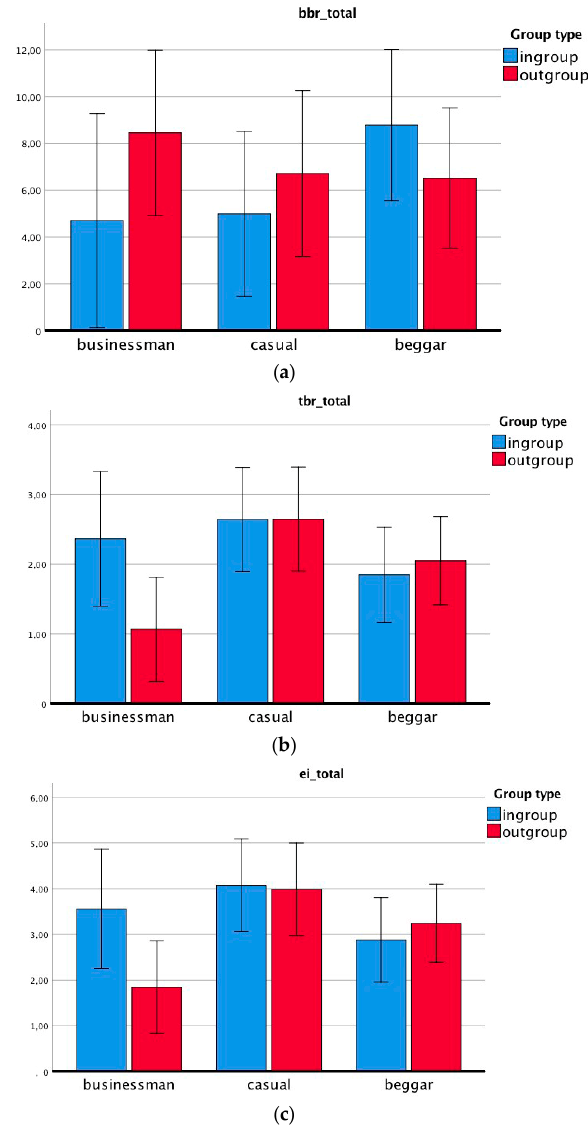
Figure 3. ( a ): Alertness. The y-axis represents the mean of alertness across the three conditions (confederate social appearance) reported on the x-axis, the color of the bars represents the variable confederate group type. Bar Errors +/ − 2 SE; ( b ): Calmness. The y-axis represents the mean of calmness across the three conditions (confederate social appearance) reported on the x-axis, the color of the bars represents the variable confederate group type. Bar Errors +/ − 2 SE; ( c ) The y-axis represents the mean of engagement across the three conditions (confederate social appearance) reported on the x-axis, the color of the bars represents the variable confederate group type. Bar Errors +/ − 2